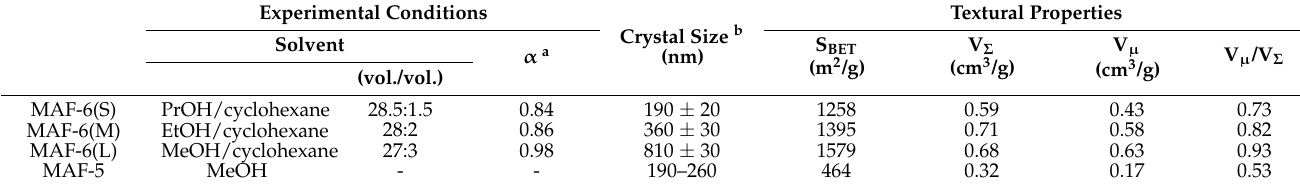
Table 3. Synthesis, abbreviation, textural properties, and crystal sizes of